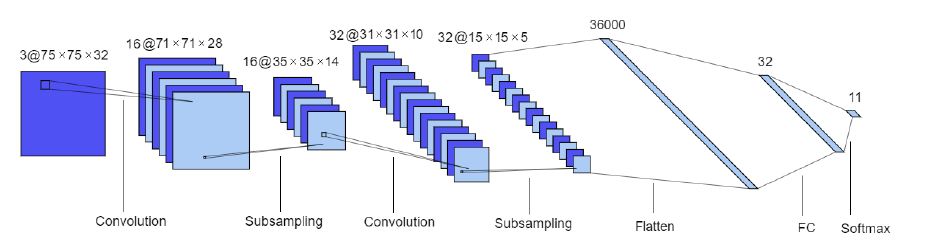
Figure 4. 3D CNN architecture. Format: number of channels or filters @ image dimension. This model is composed of two sets of convolutional and subsampling layers followed by two fully connected layers.